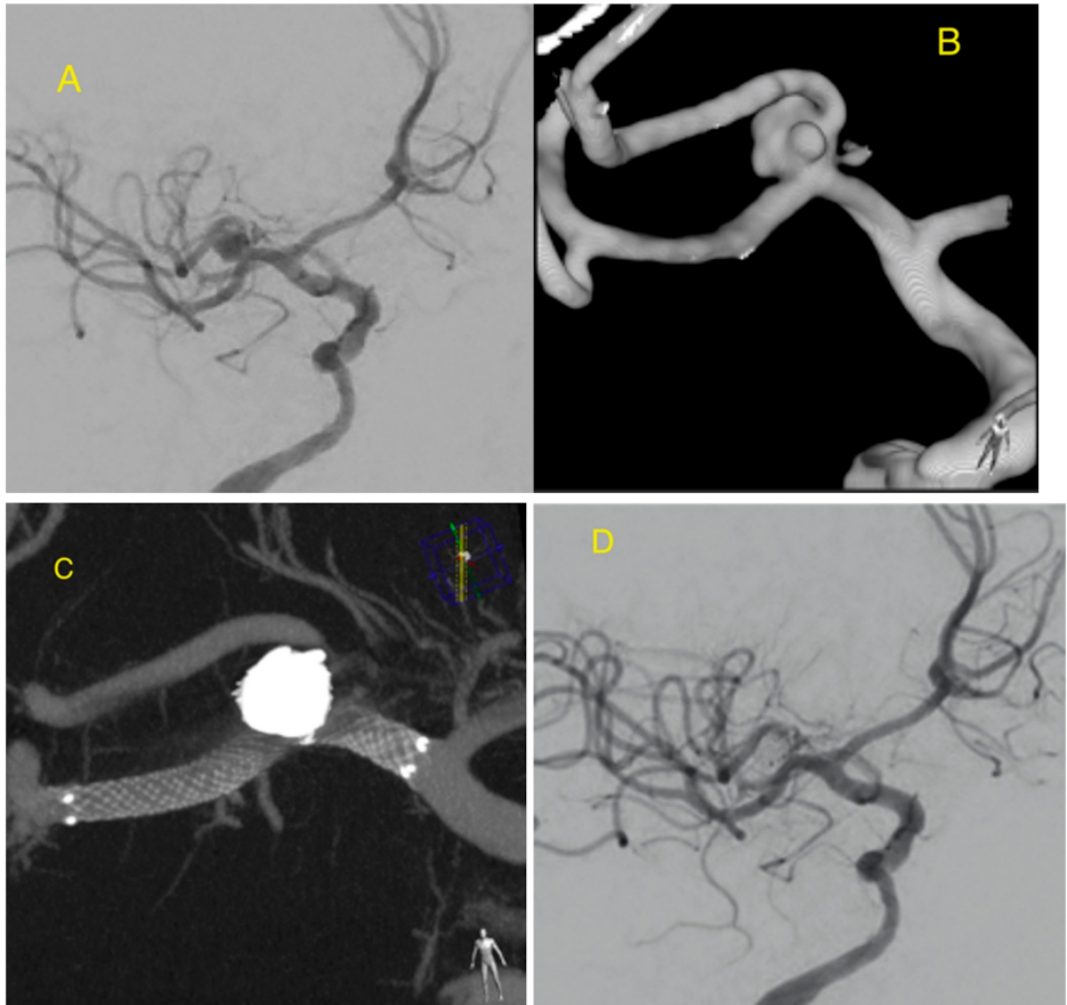
Figure 1. Right MCA bifurcation aneurysm visible on digital subtraction angiography (DSA) ( A ) and 3D reconstruction of a rotational angiography ( B ) demonstrates the aneurysm morphology of the sac and neck. The aneurysm was stented and coiled using jail technique. Excellent opposition of the stent to the vessel wall. Visible support of the coils with a stent arm which protects the aneurysm neck and parent artery ( C ). DSA shows aneurysm occlusion ( D